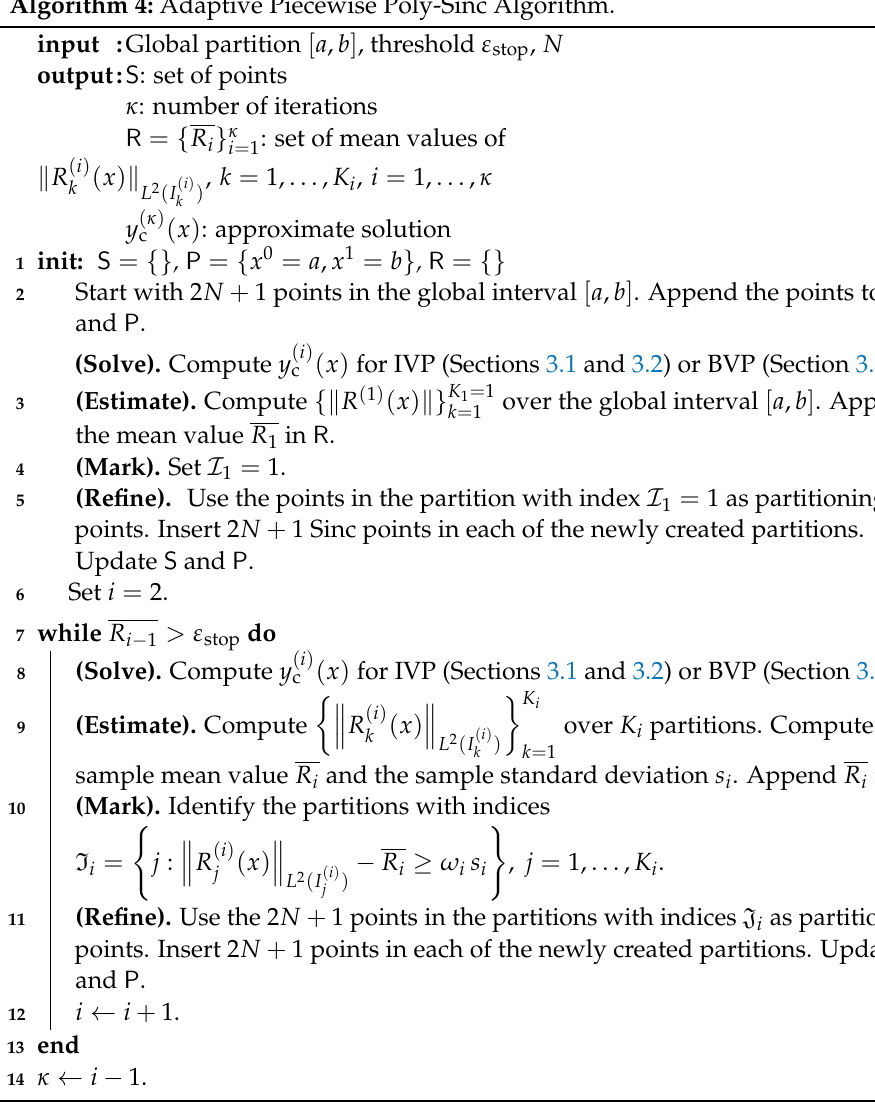
Algorithm 4: Adaptive Piecewise Poly-Sinc